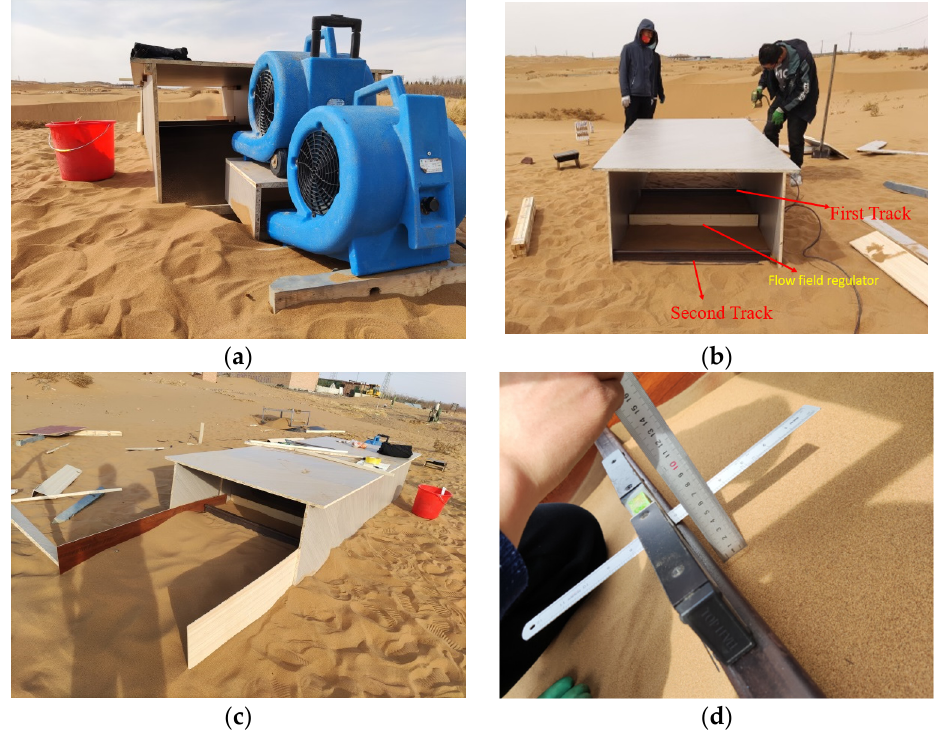
Figure 7. Schemes of Field Experiment Based on Simple Wind Tunnel. ( a ) simple experimental wind tunnel; ( b ) arrangement of the experimental devices; ( c ) general view of the experimental setup; ( d ) measurement of sediment height.